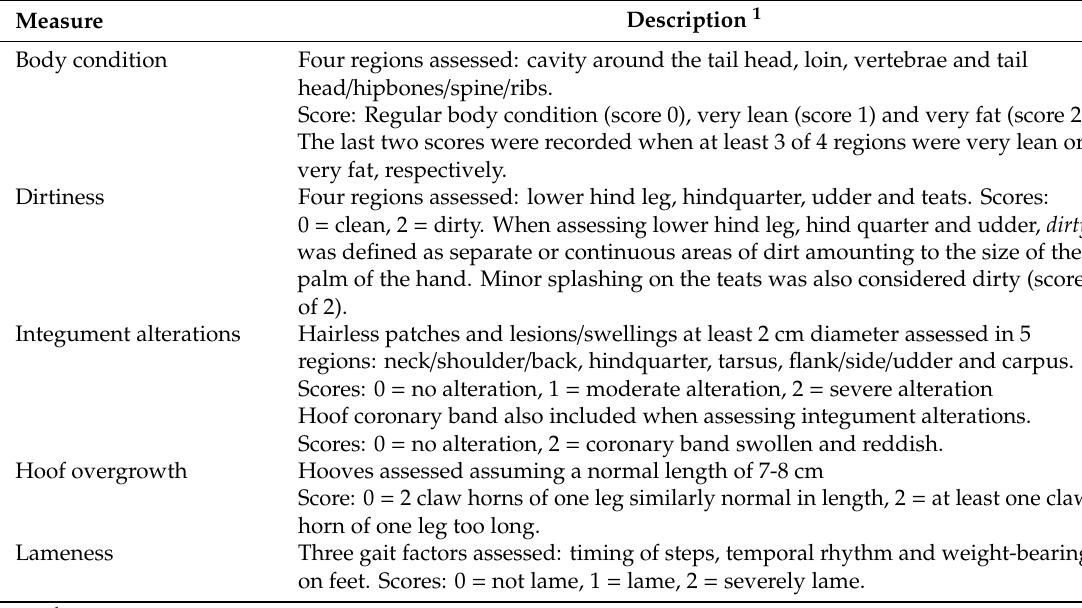
Table 1. Data collected in the on-farm